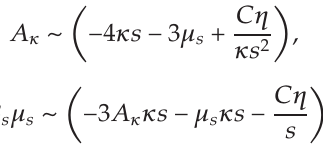
hand, from (cid:2) 4.5 (cid:3) and (cid:2) 4.10 (cid:3) lightness of h 1 and a 1 also requires λ and other term